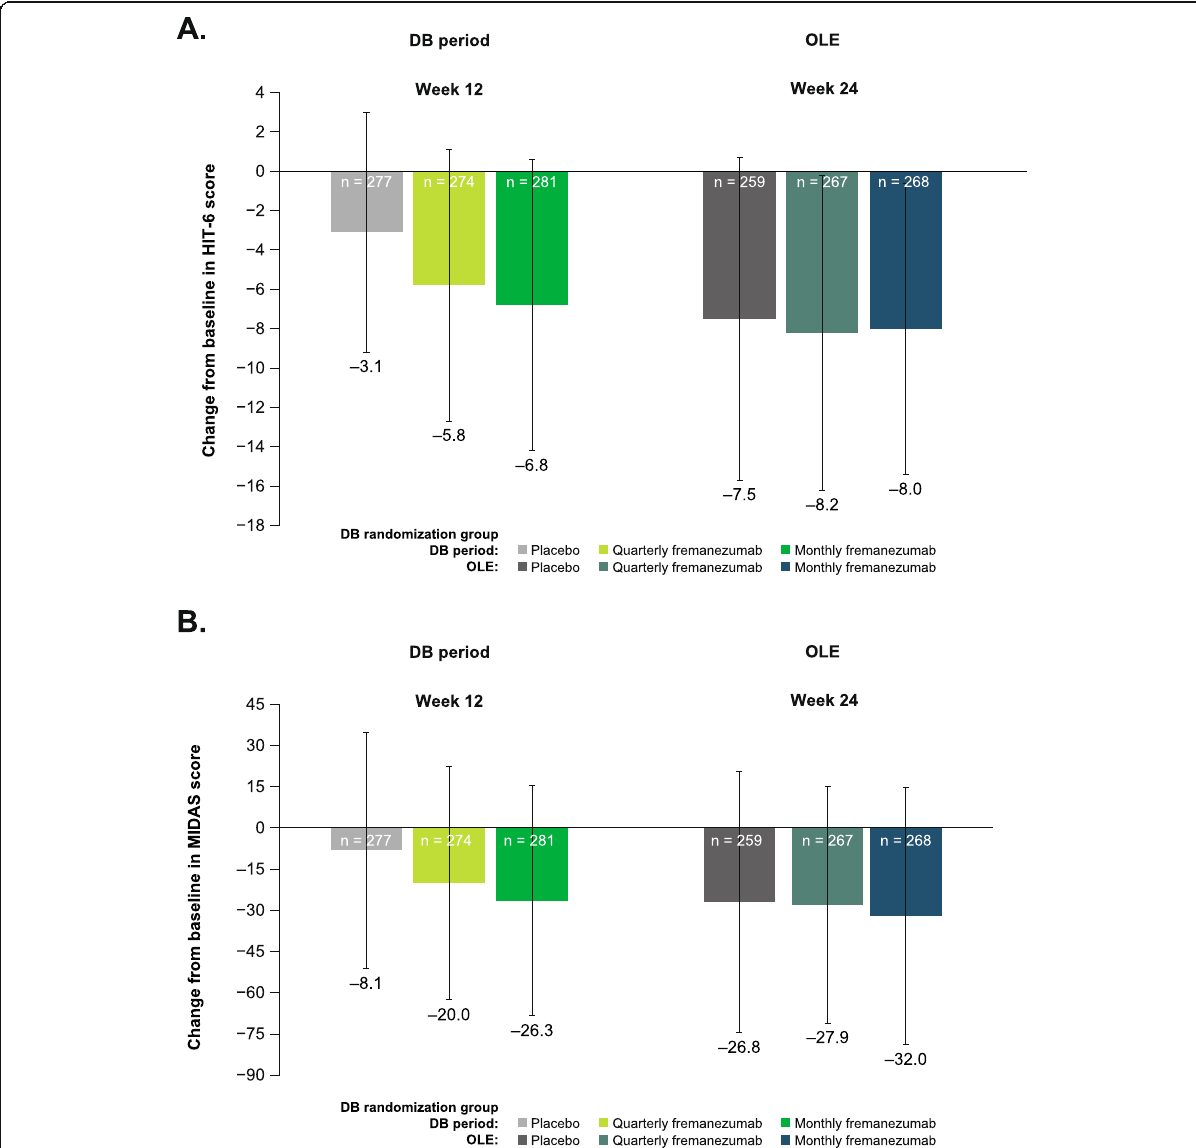
Fig. 8 Mean change in disability in the DB period and the OLE as measured by a HIT-6 and b MIDAS (mITT). a,b BL, baseline; DB, double-blind; OLE, open-label extension; HIT-6, Headache Impact Test; MIDAS, Migraine Disability Assessment; mITT, modified intent-to-treat. a All patients in